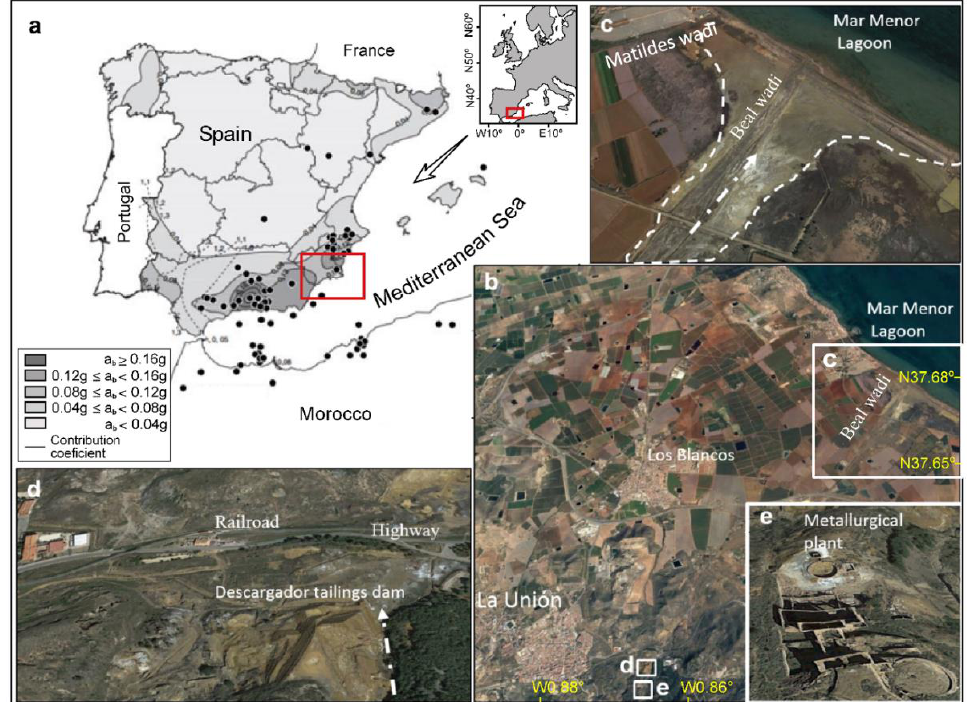
Figure 1. ( a ) Location of studied area on the Spanish seismic base map; source: NCSR-2 (2004) at Region of Murcia, ( b ) El Descargador tailings dam and its area of influence, ( c ) Beal wadis and the oxidation products of sulphides can be seen in white color in the area covered by tailings, ( d ) Cartagena – Cabo de Palos highway and the Cartagena – Los Blancos railroad affected by flow failure and ( e ) abandoned metallurgical plant. The discontinuous arrow indicates the direction of the runoff. Base maps orthorectified aerial photographs; source Spanish National Geographic Institute (IGN). Schemes follow the same formatting.